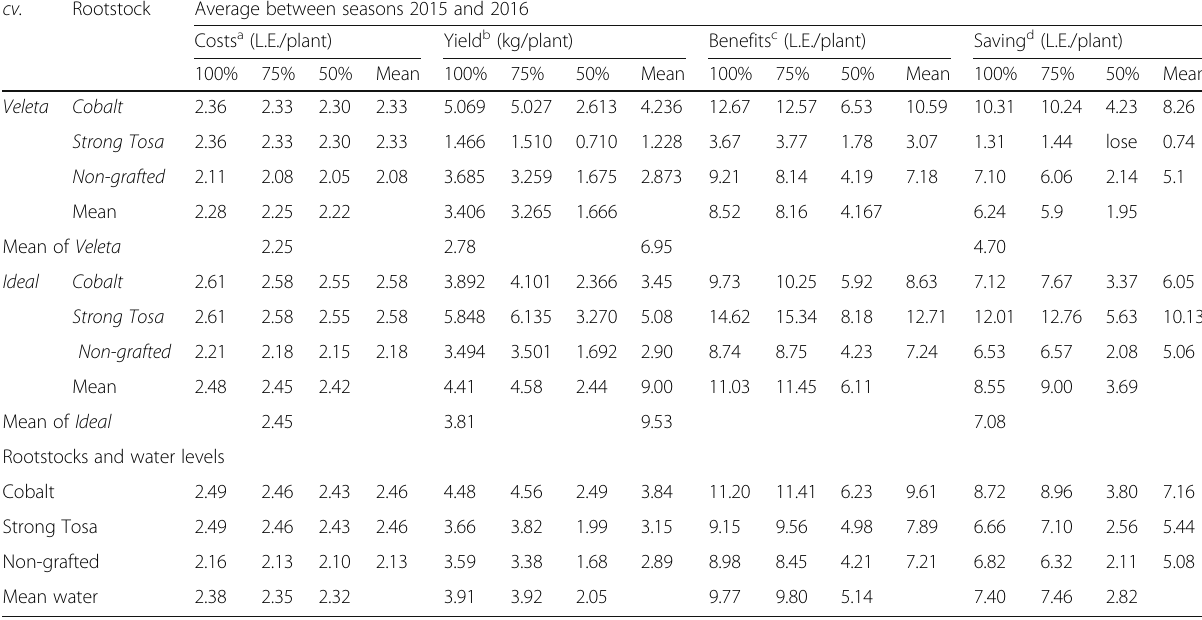
Table 7 Effect of deficit irrigation rates, cultivars and rootstocks on costs and benefits of cantaloupe plants as the average between seasons 2015 and 2016 cv. Rootstock